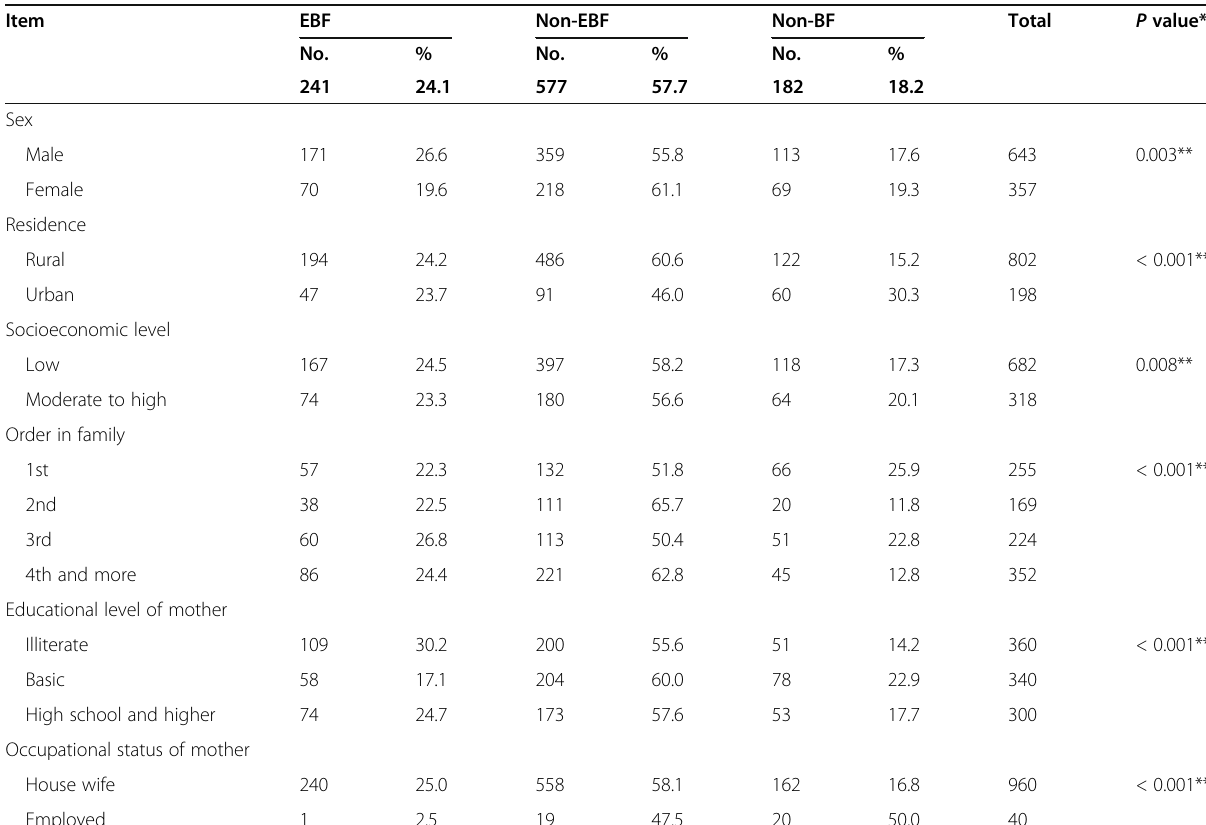
Table 2 Factors affecting patterns of infant feeding